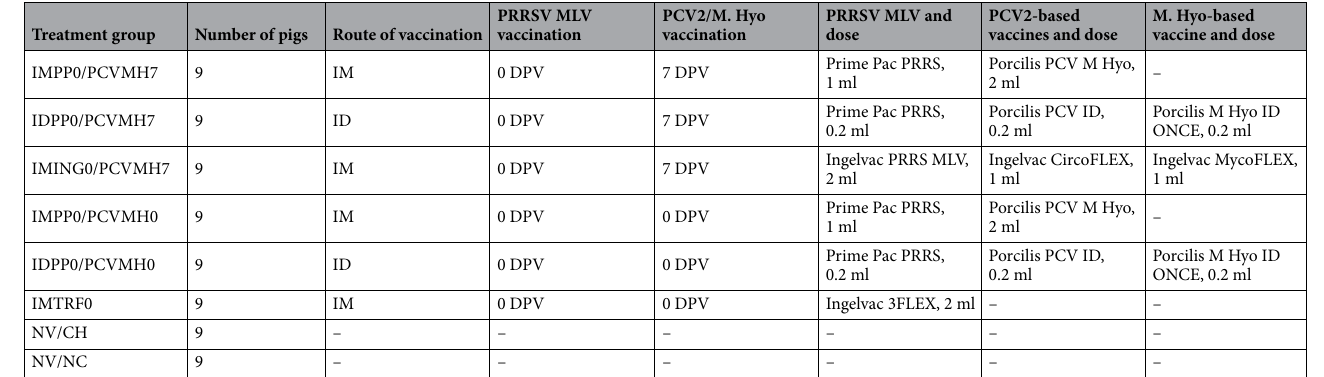
Table 1. Experimental design in the present study. Eight treatment groups include 6 vaccinated groups and 2 non-vaccinated groups. Routes of vaccine administration were included either intramuscular (IM)